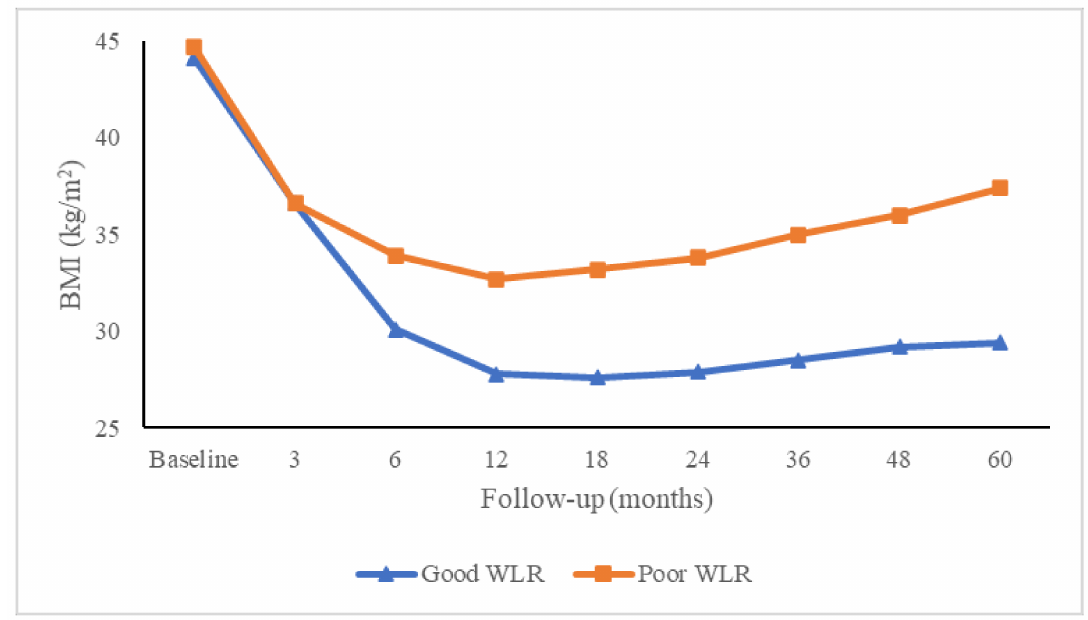
Figure 3. Changes in BMI of good and poor weight loss responders during follow-up after the bariatric surgical procedure. BMI = body mass index; WLR = weight loss